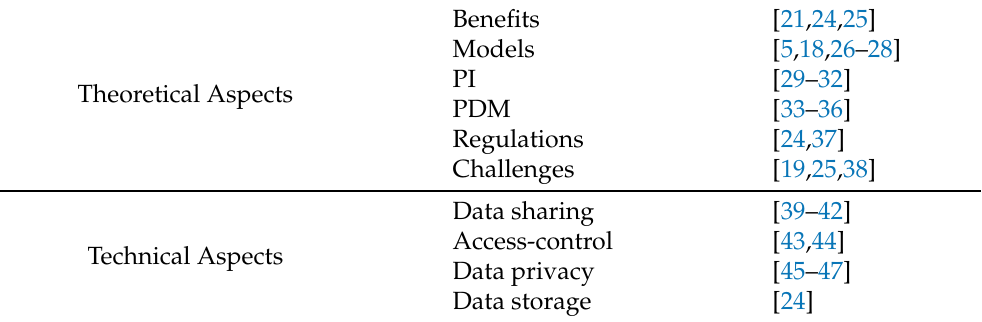
Table 2. Taxonomy of topics related to Personal Data Stores